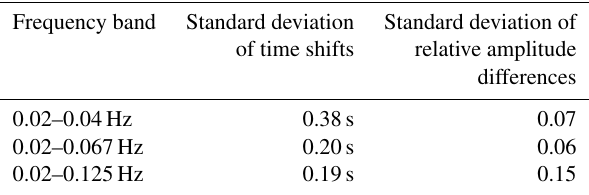
Table 2. Standard deviations of time shifts and relative amplitude differences as a function of frequency